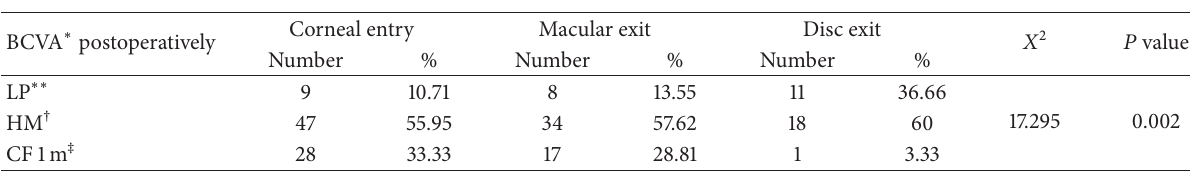
∗ BCVA: best corrected visual acuity.